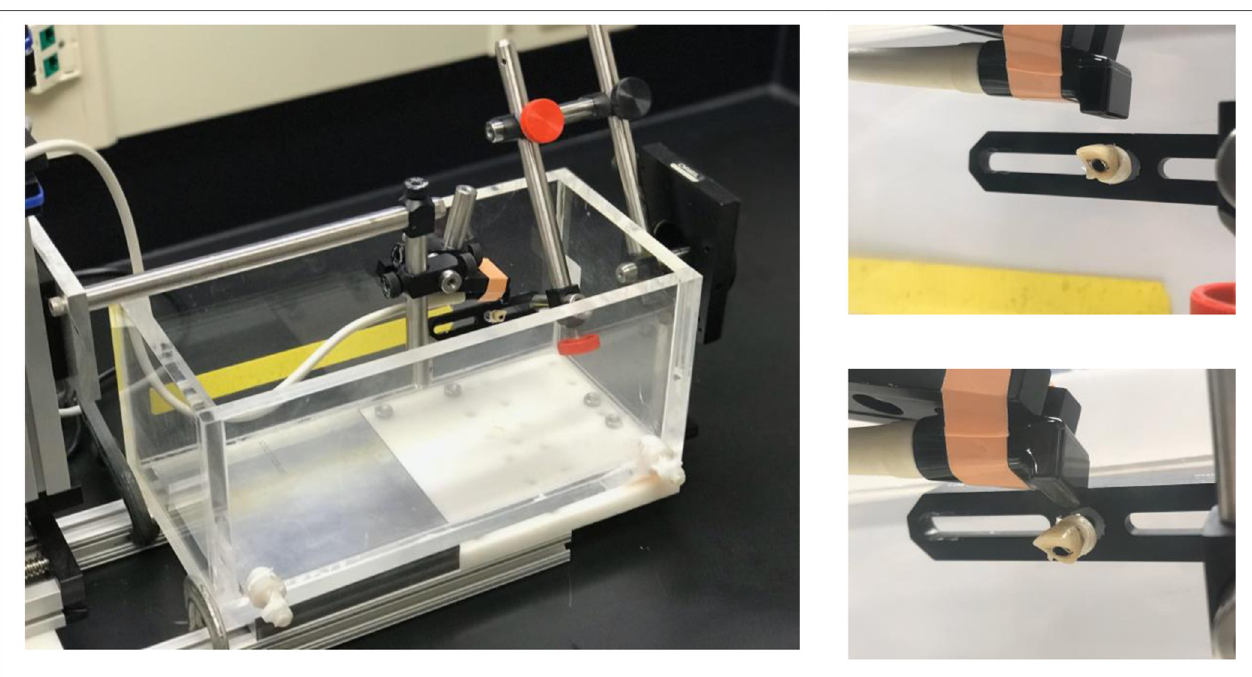
Fig 1. Experimental setup of this study. Left: (Empty) water tank to allow for acoustic coupling to the specimens, the rotational positioner, and the ultrasound probe. Right-top: Filled-water tank with imaging probe parallel (0˚) with respect to the sample. In this image, a temporary crown is demonstrated. Right- bottom: The probe is at a large angle (+30˚) with respect to the sample.